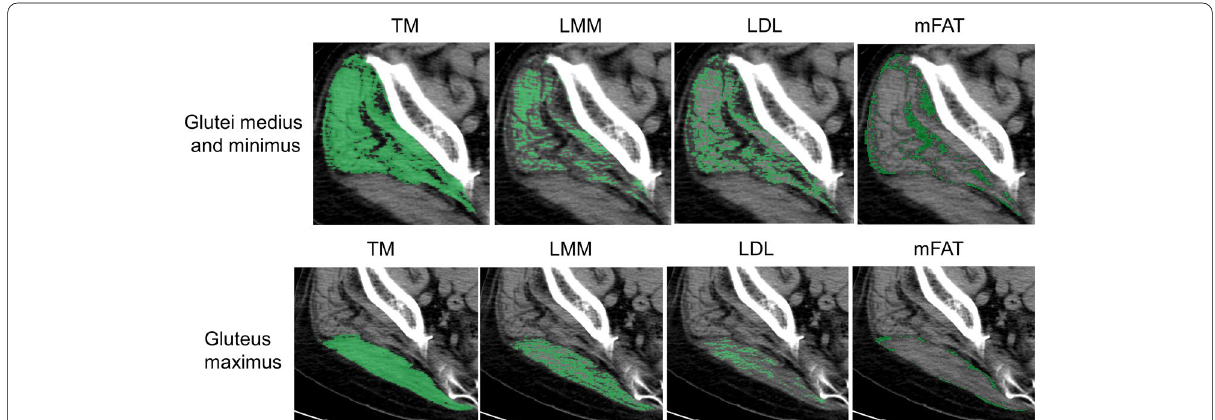
Fig. 1 Measurement of muscle composition on an axial image of computed tomography. Total muscle cross-sectional area (TM) of the glutei medius and minimus or the upper portion of the gluteus maximus is segmented using the threshold of muscle mass (LMM), low-density lean tissue (LDL), and intramuscular fat (mFAT) are colored as the pixels with the density of 30 to 80 HU, 0 to 29 HU, and 190 to 30 HU, respectively, within each segmented − −